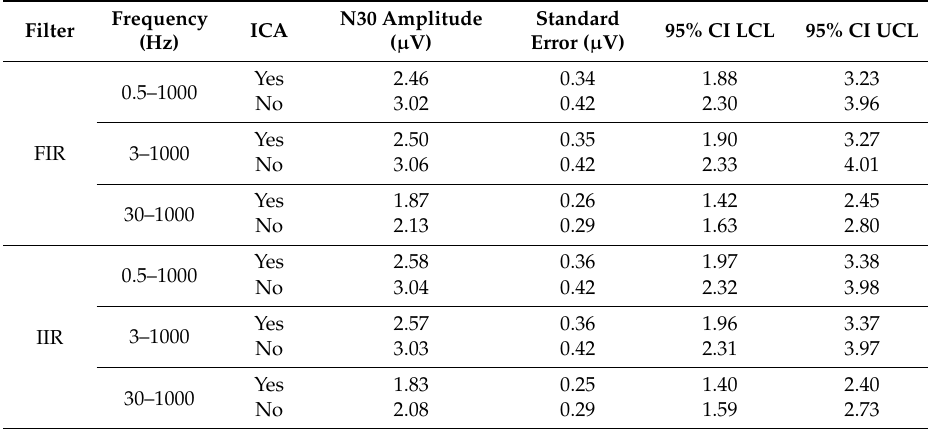
Table 3. Estimated N30 amplitude from the statistical model. Abbreviations: LCL = Lower